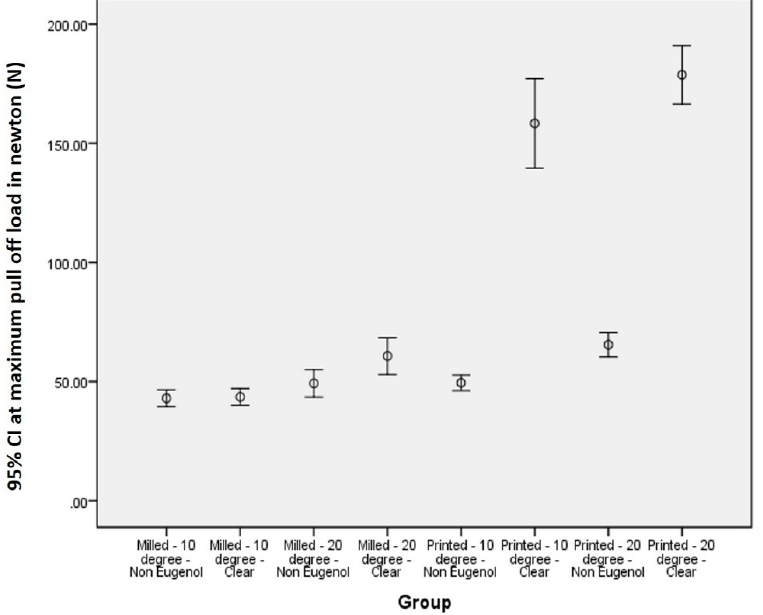
Figure 8. Intergroup comparison of 95% CI relative to pull-off force (N) in the test groups. * Statistically significant.